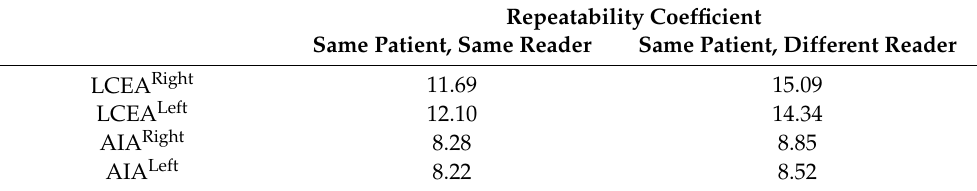
Table 6. Estimated repeatability coefficients for between and within reader measurements based on the linear effects model. Five human readers, LCEA and AIA. (n =